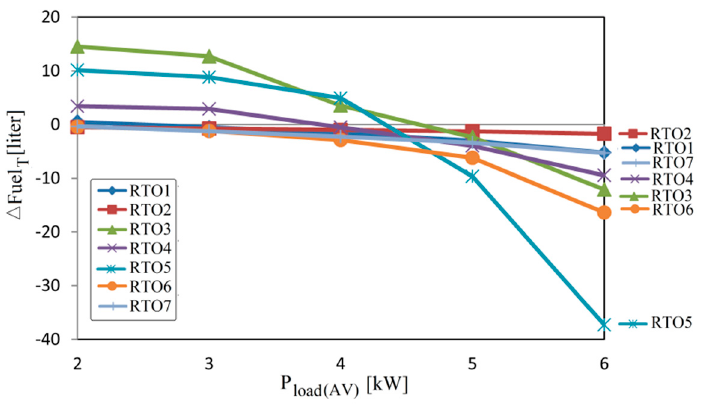
Figure 7. Fuel saving for k fuel = 50 and different P load(AV) .